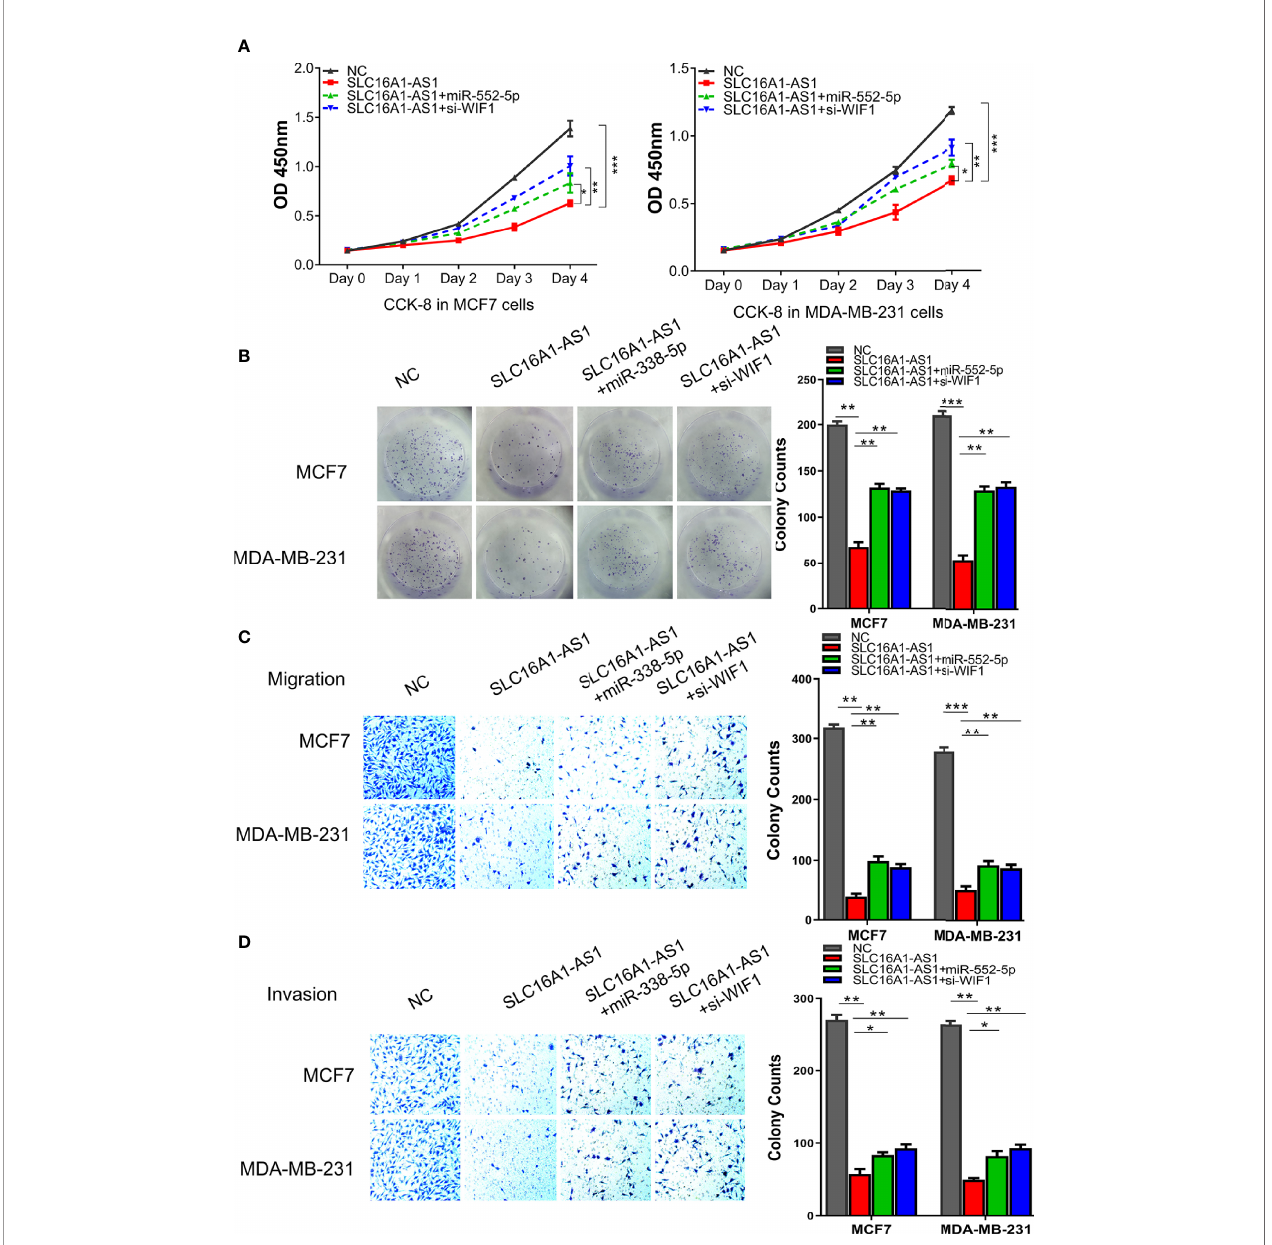
FIGURE 6 | miR-552-5p overexpression or WIF1 knockdown reverses SLC16A1-AS1-attenuated BC aggressive behavior. To verify the functions of the SLC16A1- AS1/miR-552-5p/WIF1 axis in BC cells, the viability (A) , colony formation (B) , cell migration (C) , and cell invasion (D) in MDA-MB-231 and MCF7 cells after SLC16A1-AS1 overexpression (SLC16A1-AS1) with or without miR-552-5p overexpression by miR-552-5p mimics (miR-552-5p) or WIF1 silenced with small interfering RNA (si-WIF1) were studied, respectively. * p < 0.05, ** p < 0.01, *** p <